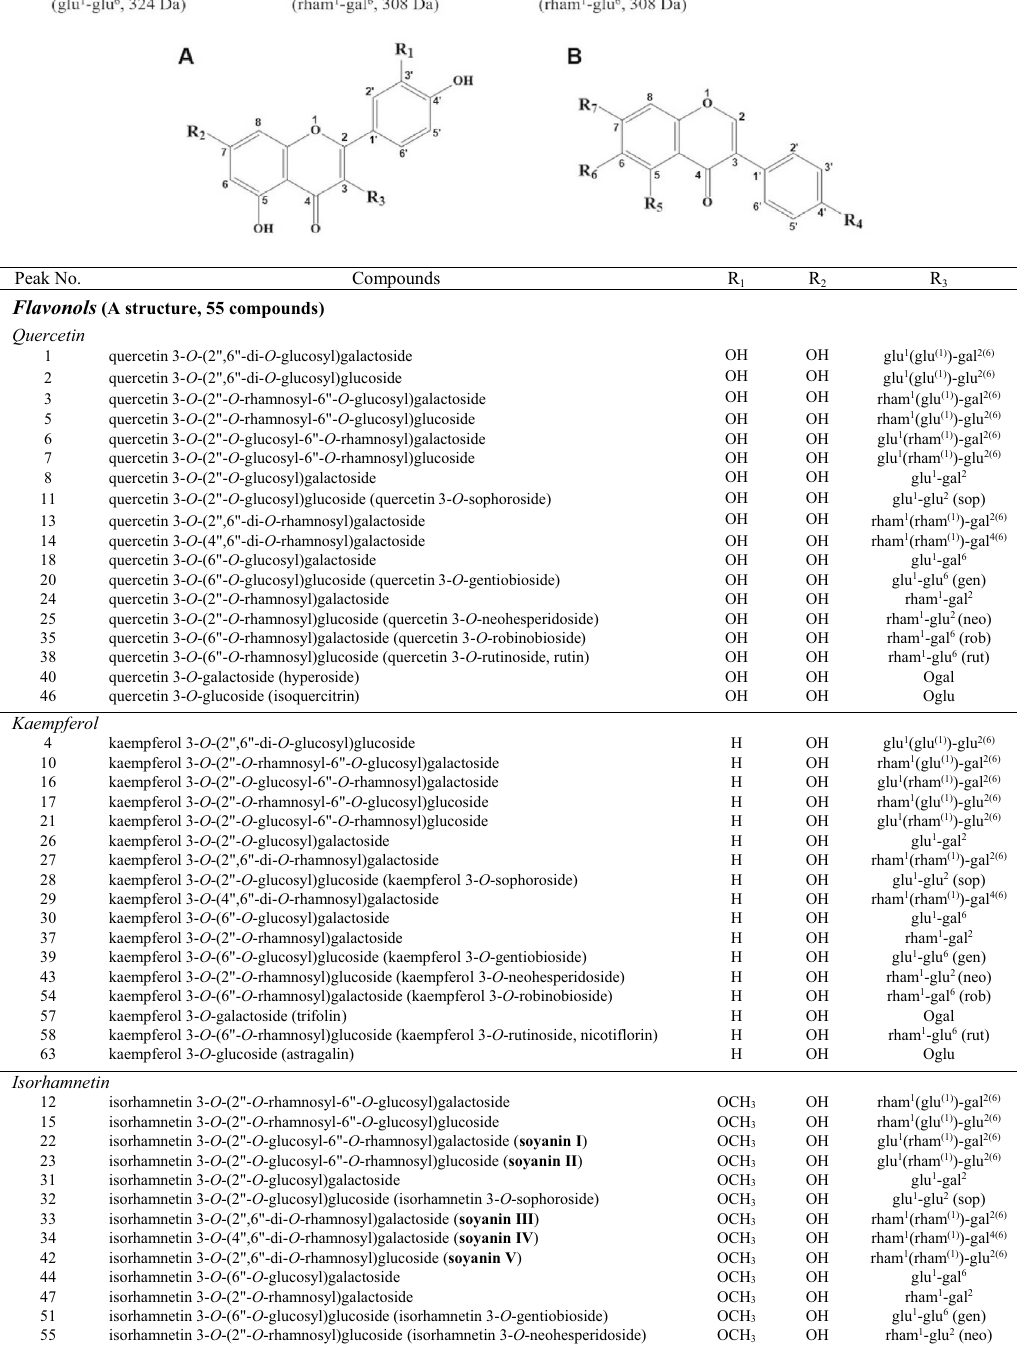
Figure 1. Chemical structures of eighty-three flavonoid derivatives ( A , 55 flavonols and 9 flavones; B , 19 isoflavones) presented from young leaves of 21 soybean cultivars. mal, malonyl; api, apiose; gal, galactose; glu, glucose; rham, rhamnose; gen, gentiobiose; rob, robinobiose; rut, rutinose; neo, neohesperidose; sop,